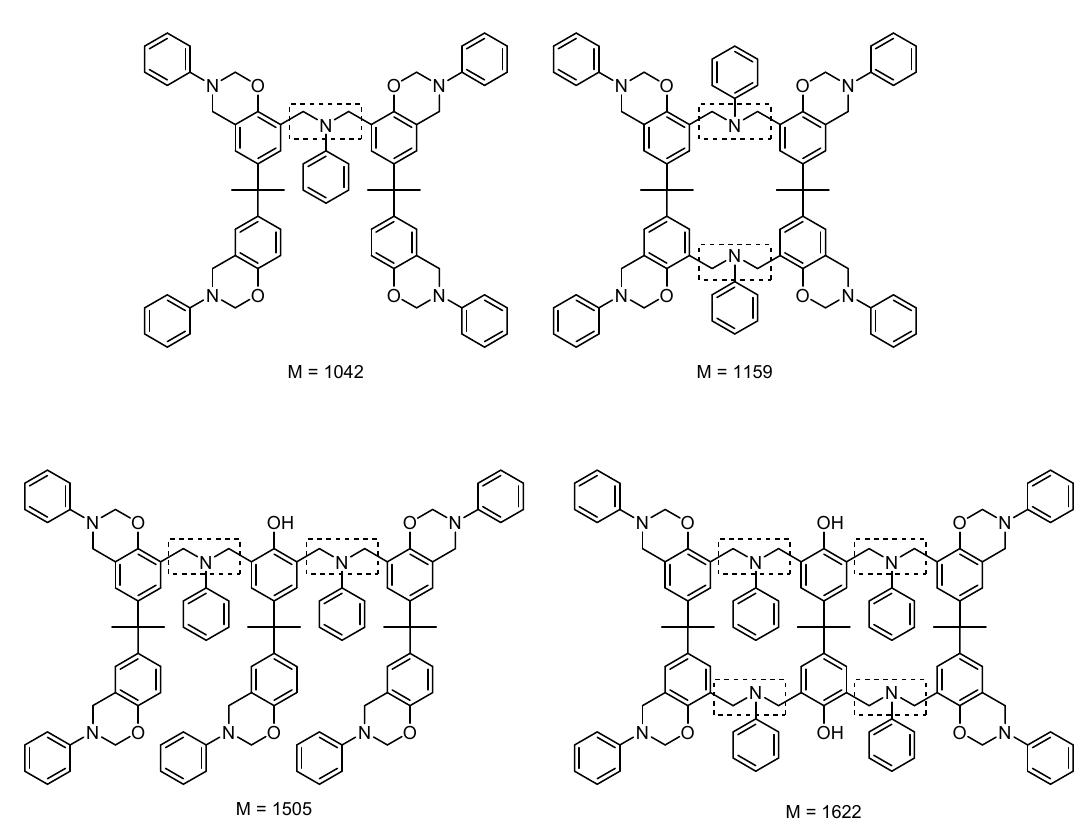
Figure 2. Formulas of dimers and trimers with aminomethylene Mannich bridges (marked with dashed line), the formation of which is possible during the synthesis of BA-a benzoxazine monomers according to Scheme 1.